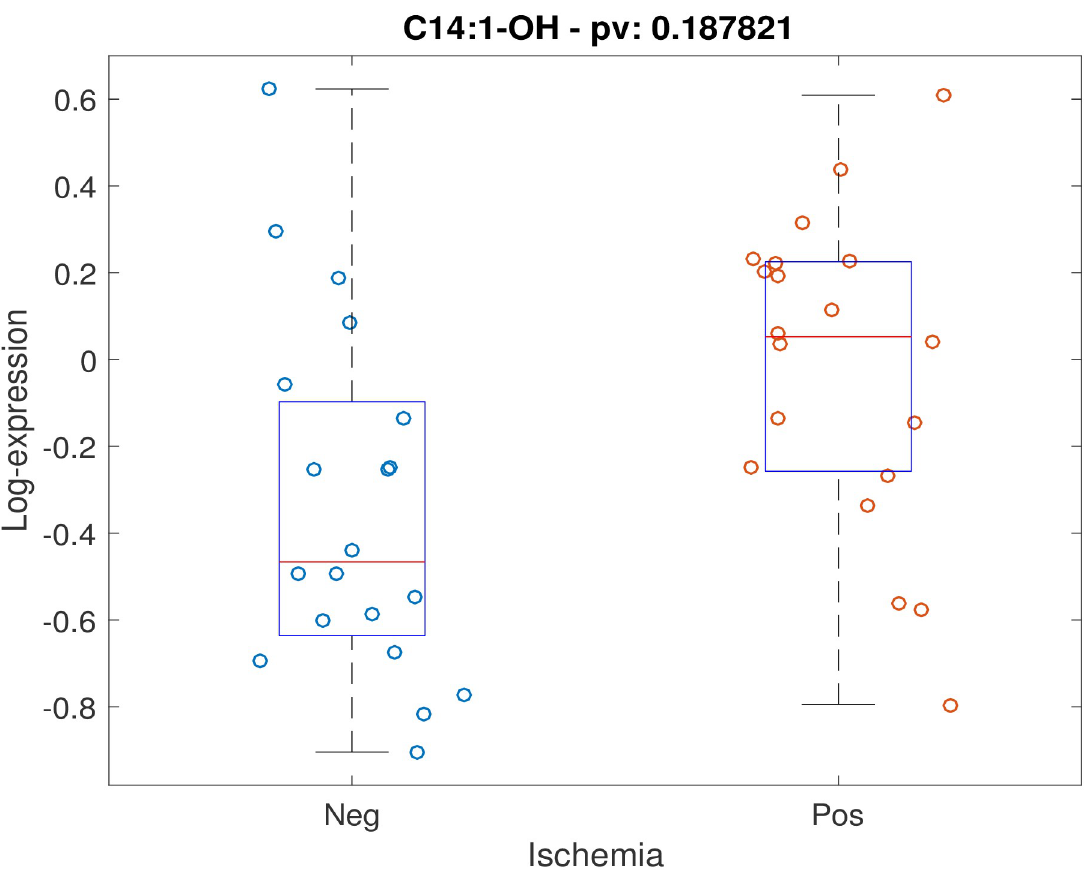
Fig 3. Scatter plot of stress-delta in C14:1-OH for patients who were positive versus negative for ischemia. When assessing changes in metabolite levels across timepoints while controlling for age, gender and BMI, 5 metabolites had FDR < 0.2: alanine, C14:1-OH, C16:1, C18:2,